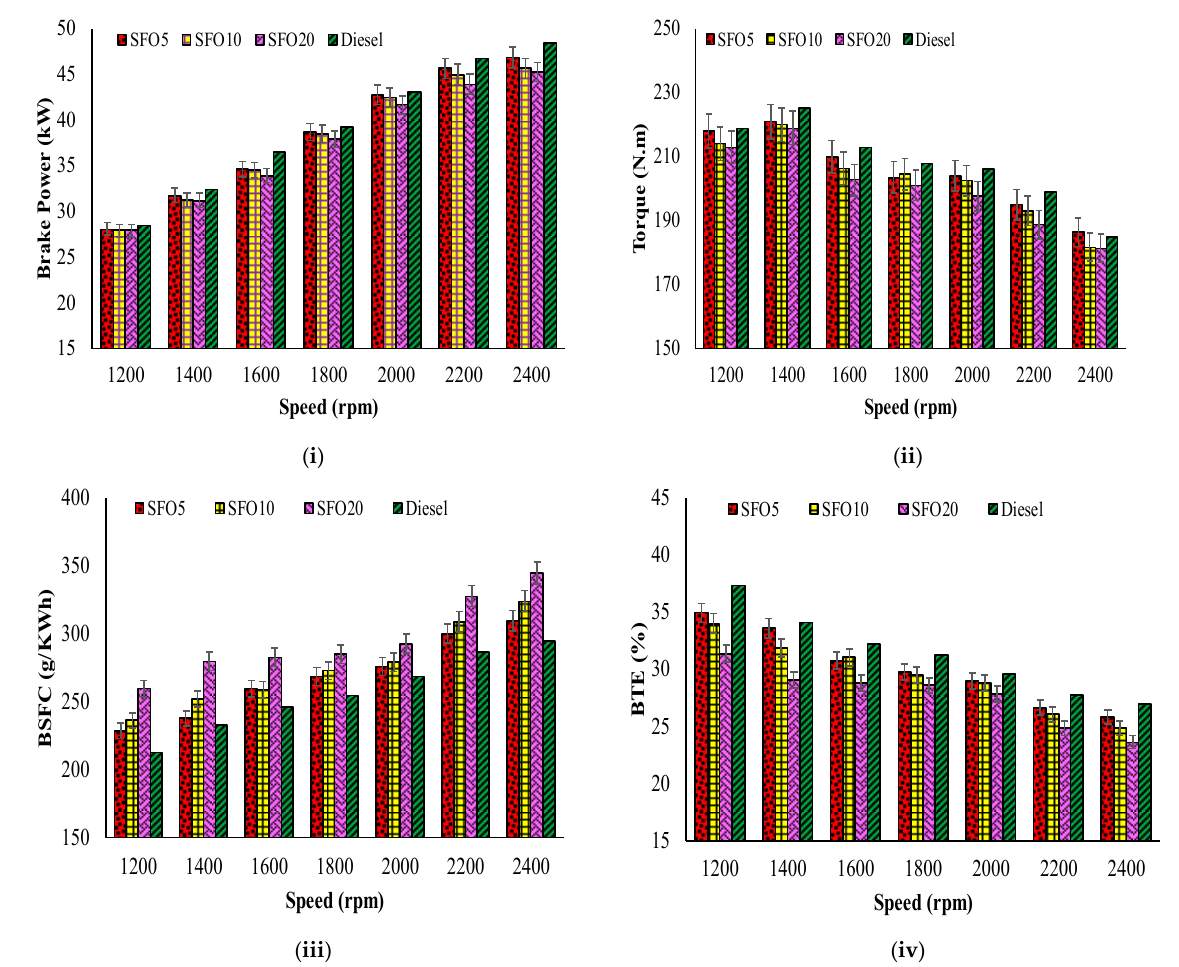
Figure 5. Variation in engine performance with engine speeds.